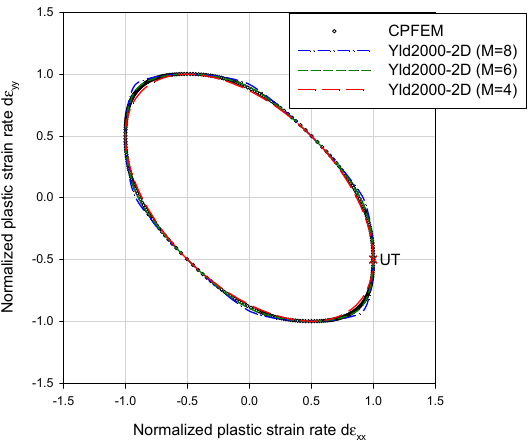
Figure 2. Comparison of the calculated strain-rate potentials based on crystal plasticity simulations and isotropic version of the Yld2000-2D function.